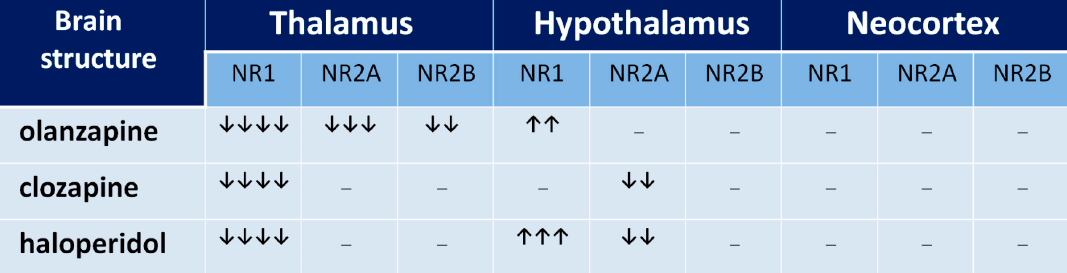
Figure 5. The influence of chronic neuroleptic administration on NMDA receptor subunits’ expression in thalamus, hypothalamus, and cortex in rats. Arrows indicate the subunit expression decrease or increase by 0–25% ( ↓ ), 26–50% ( ↓↓ ), 51–75% ( ↓↓↓ ), and 76–100% ( ↓↓↓↓ ).